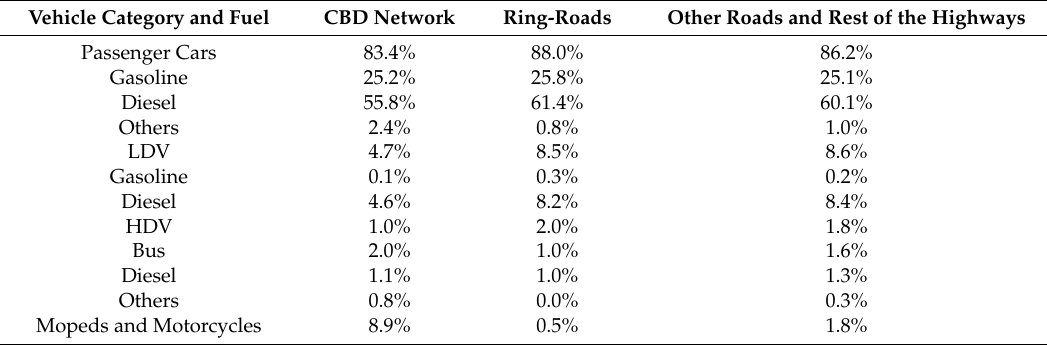
Table 1. Madrid’s circulating fleet by category and fuel and zone